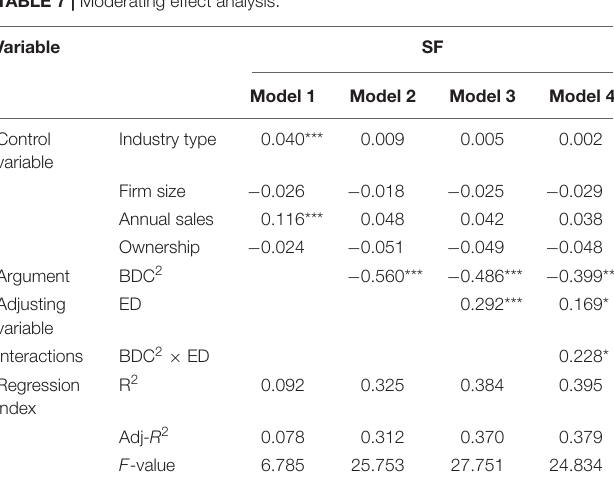
TABLE 7 | Moderating effect